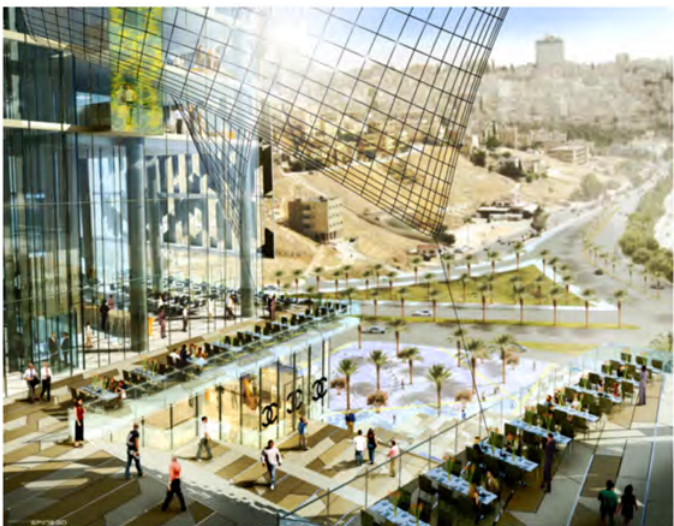
Figure 15. Sanaya Amman (Limitless towers) proposal render. Source; Consolidated Consultants (2014)